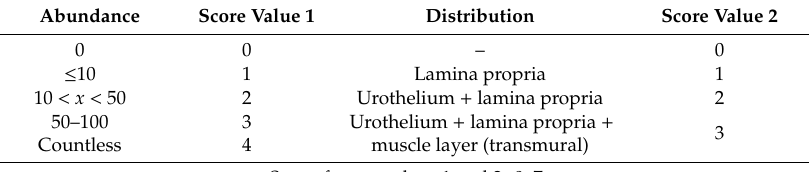
Table 4. Scoring system for semi-quantitative assessment of neutrophil